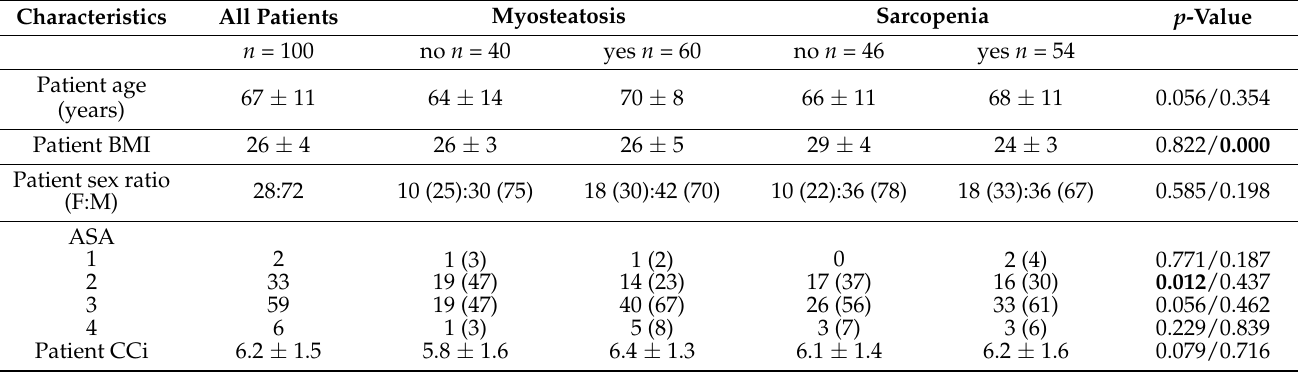
Table 1. Patient